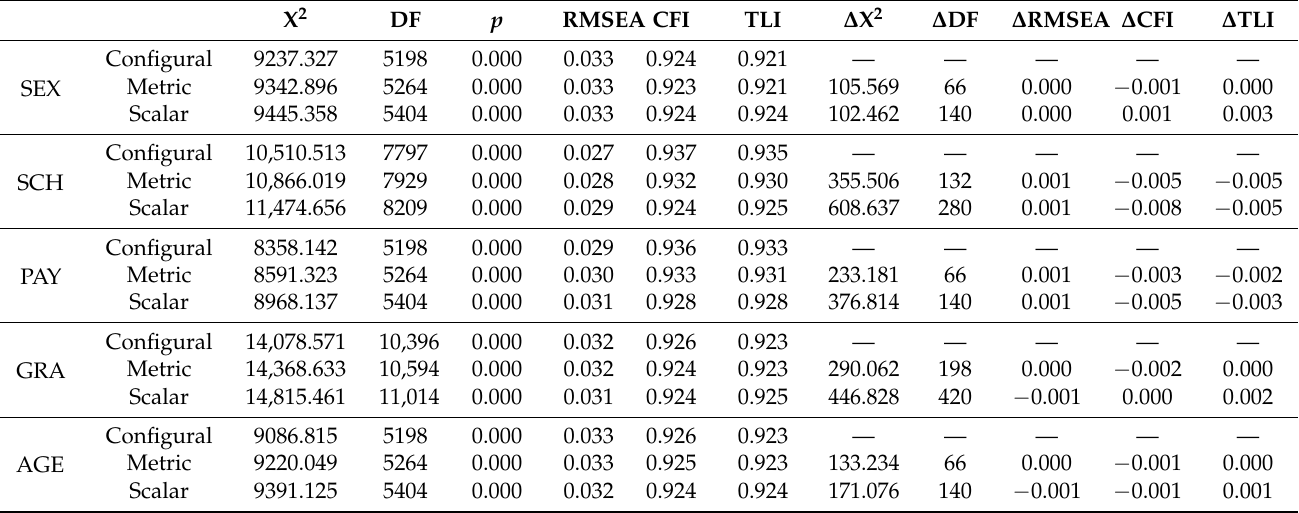
Table 11. Measurement invariance test, other categories. Source: Prepared by the authors.